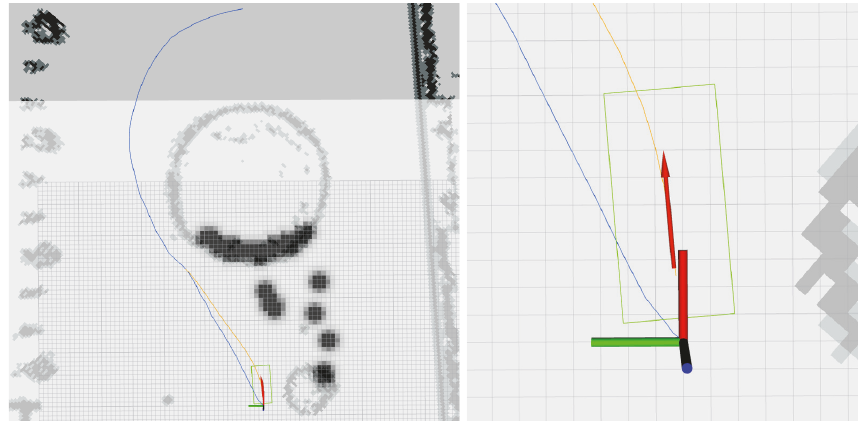
Figure 10: Global plan in blue. Local plan in orange. Overlay of global map and local Costmap 2D.